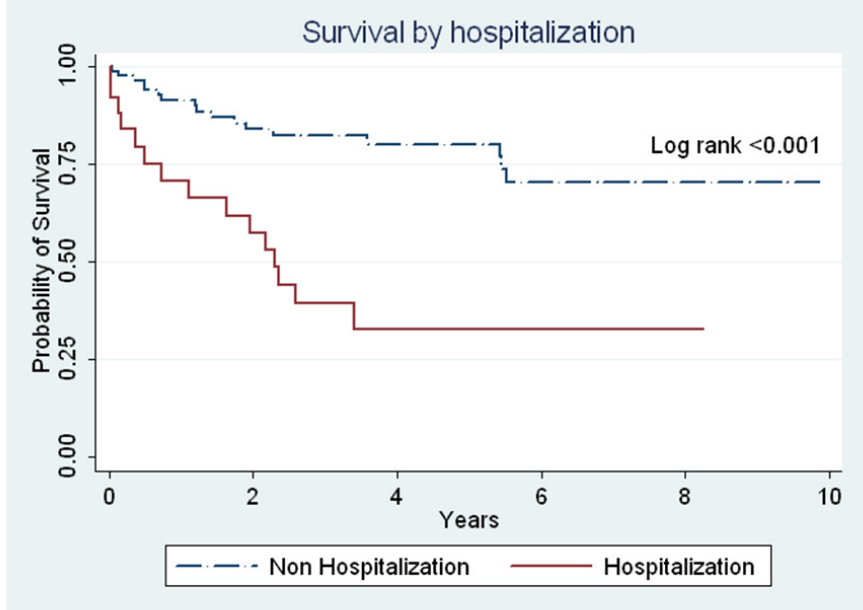
Figure 3. The survival of the entire cohort from initial diagnosis to death, last follow-up, or at the end of the study period. A comparison between patients with respiratory hospitalization and those with non-respiratory hospitalization (mean survival, 3.6 years vs. 7.6 years; p < 0.001) is given. Table 3. Primary causes of death for different conditions.